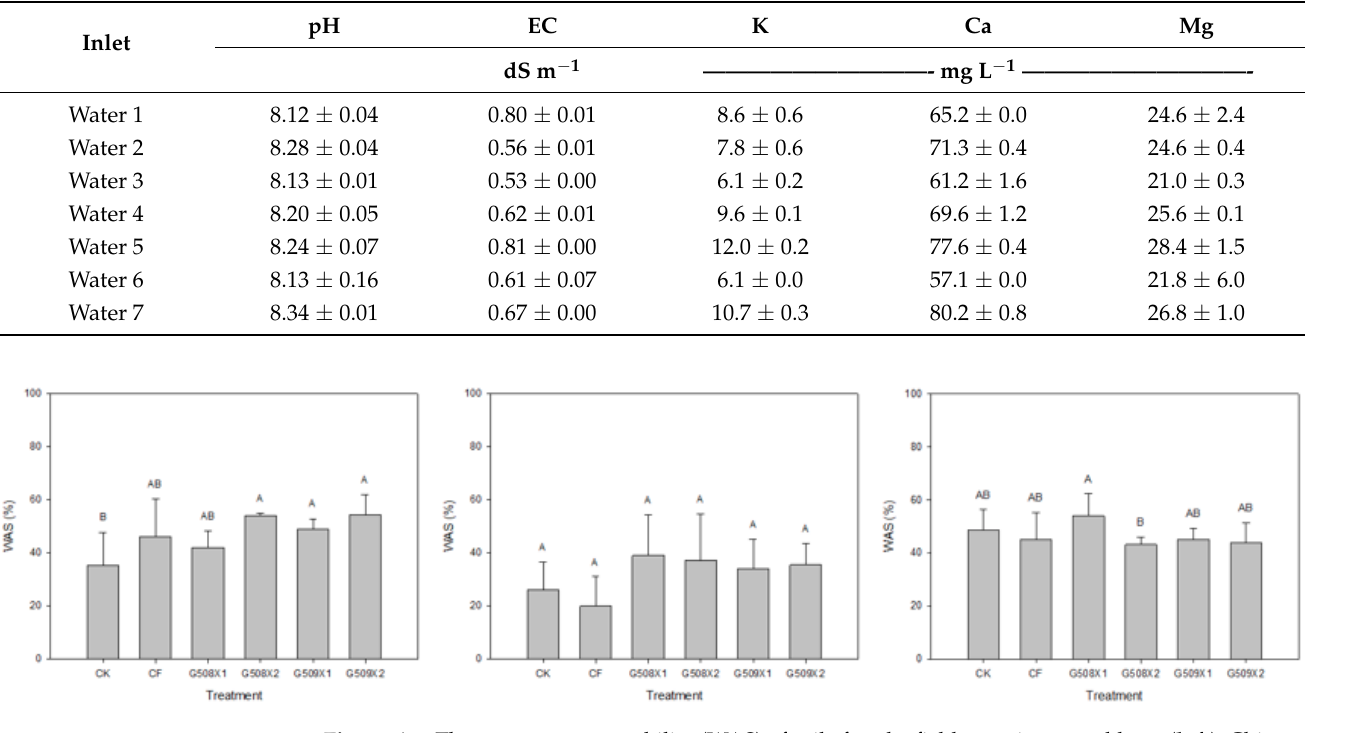
Figure A1. The wet aggregate stability (WAS) of soil after the field experiment: cabbage ( left ), Chinese cabbage ( middle ), and water spinach ( right ). The different letters indicate the significance among the treatments obtained through one-way ANOVA analysis (Duncan test, p < 0.05, n = 4). The codes have the same meanings as those in Figure 1.